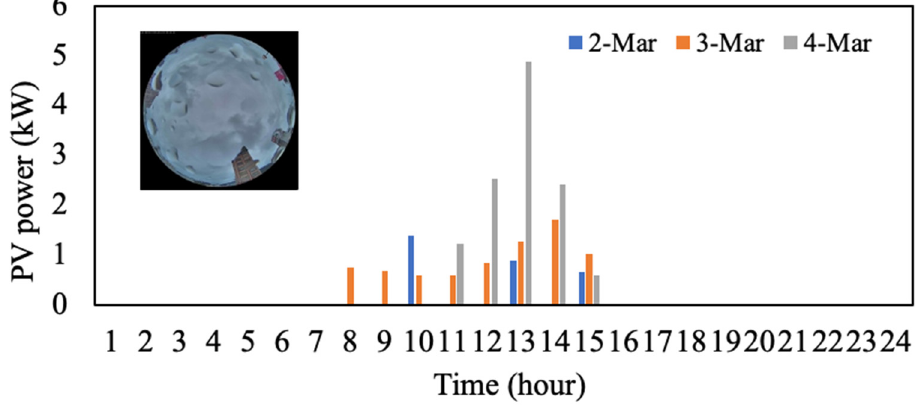
Figure 3. The historical photovoltaic forecast data graph and the weather condition photo captured by the sky camera from 2–4 March 2021.